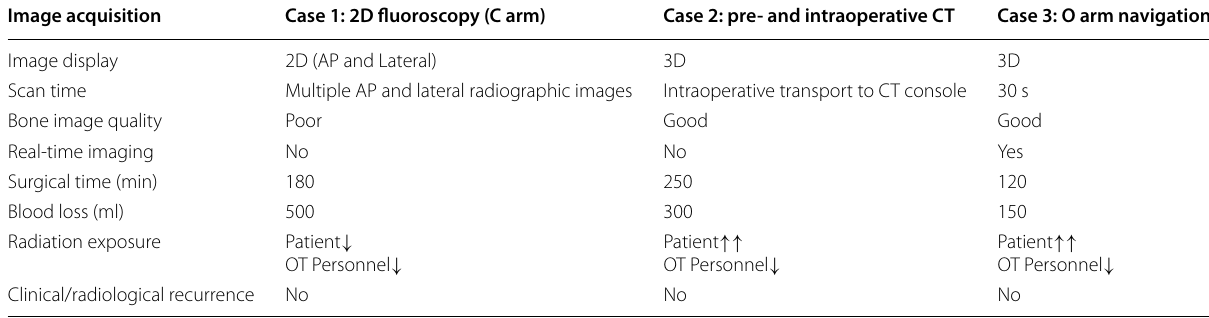
Table 1 Case-wise comparison of intraoperative radiological and surgical parameters Image